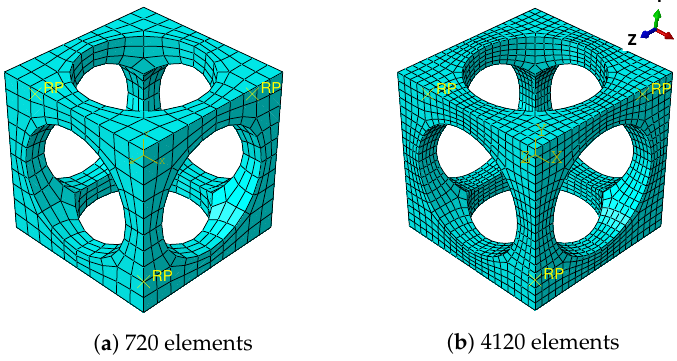
Figure 1. Architected RVE with fine meshes and reference points (RPs).